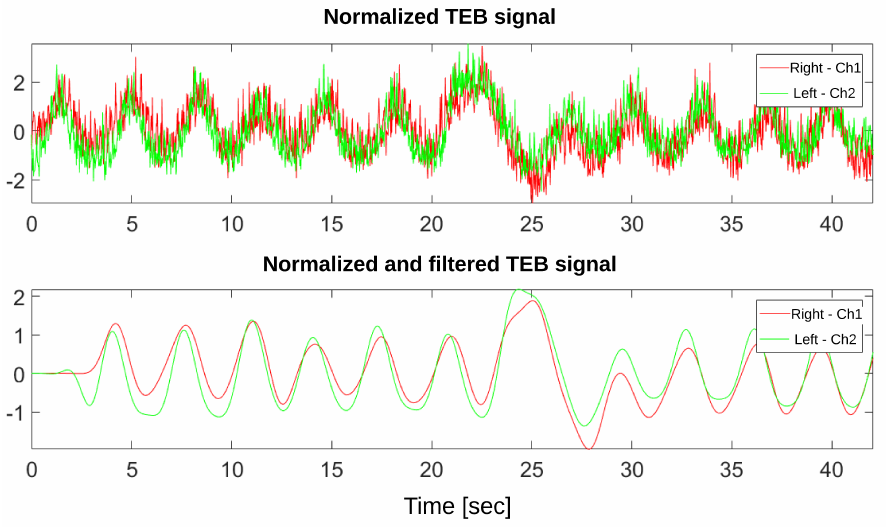
Figure 10. Normalized and unfiltered TEB variation signals from both channels (upper) and filtered and normalized TEB variation signals from both channels